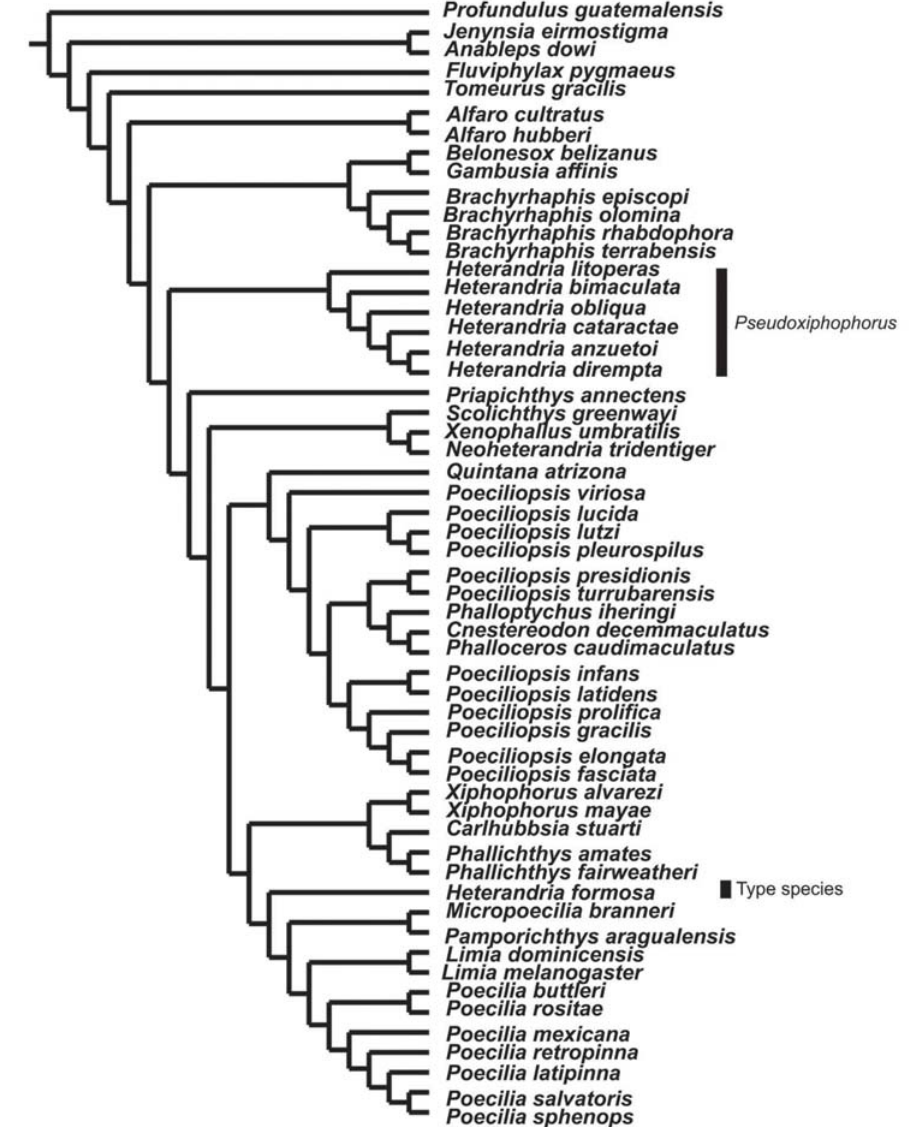
Fig. 2. Single MP tree with multistate characters analyzed as unordered, and with a posteriori weighting using RC (1,444 steps, CI = 0.20, RI = 0.47, RC